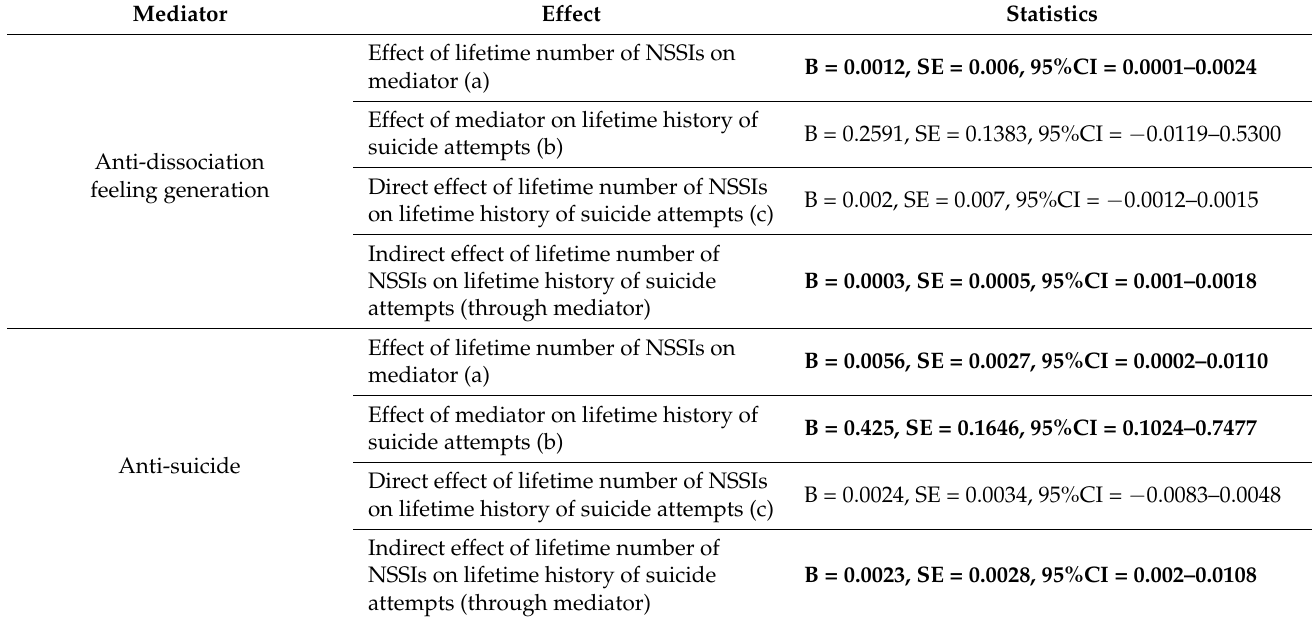
Table 3. Results of mediation analysis.